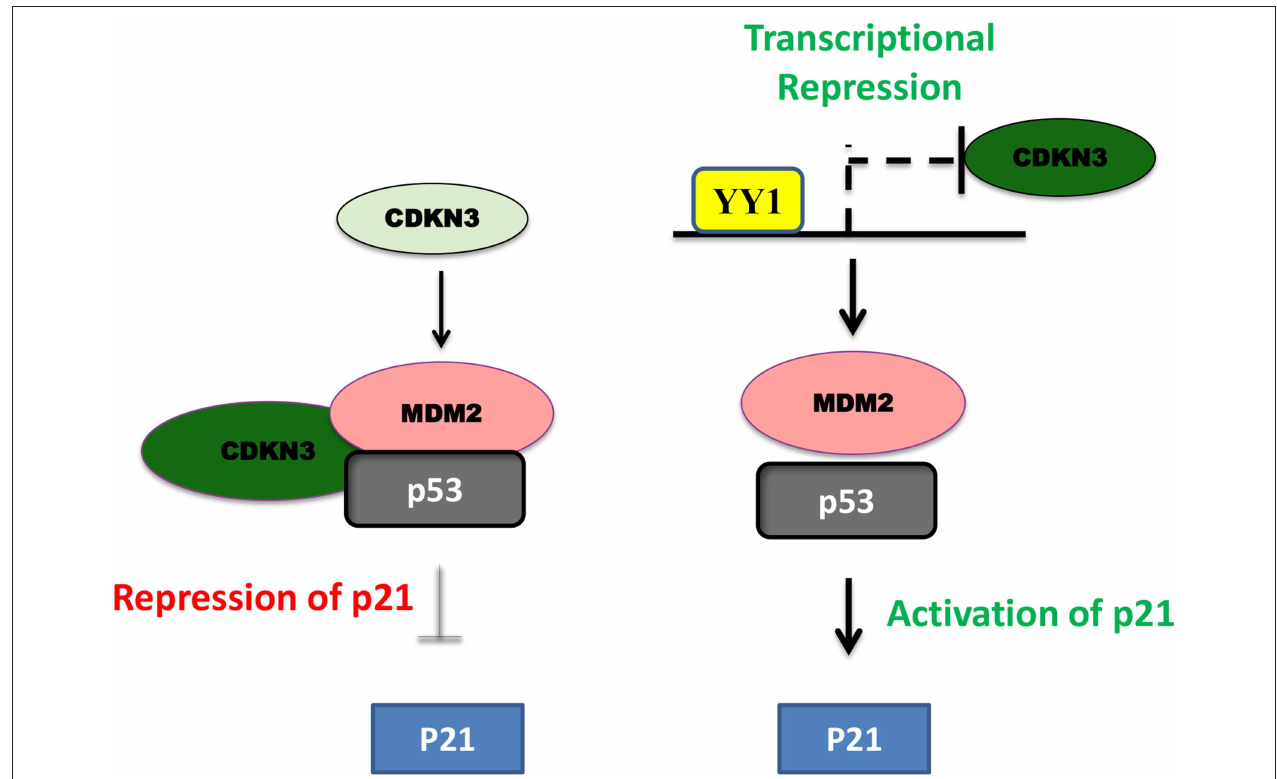
FIGURE 3 | Schematic representation of YY1-CDKN3-MDM2 interaction and its functional significance in cancer. In pancreatic cancer, CDKN3 was shown to form a complex with MDM2-p53 and inhibit p53 dependent upregulation of p21 leading to tumor cell proliferation. YY1 was shown to transcriptionally repress CDKN3 and thereby promote p53 dependent p21 expression and impair in pancreatic cancer cell